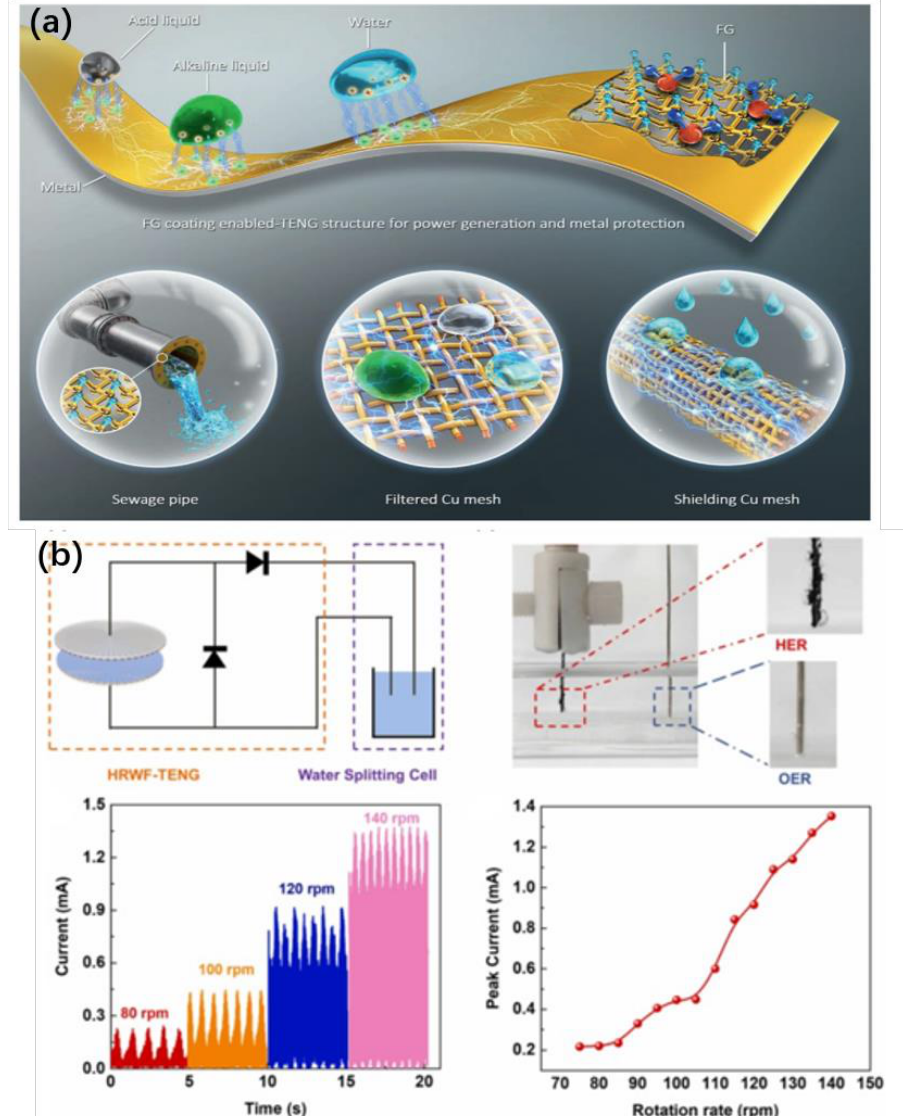
Figure 13. ( a ) Fluorinated graphene-enabled durable triboelectric coating for water energy harvesting (reproduced with permission from [159]. 2021 Wiley-VCH GmbH, Weinheim, Germany). ( b ) A half-wave rectifying triboelectric nanogenerator for self-powered water splitting toward hydrogen production (reproduced with permission from [160]. 2021 Elsevier Ltd., Singapore).